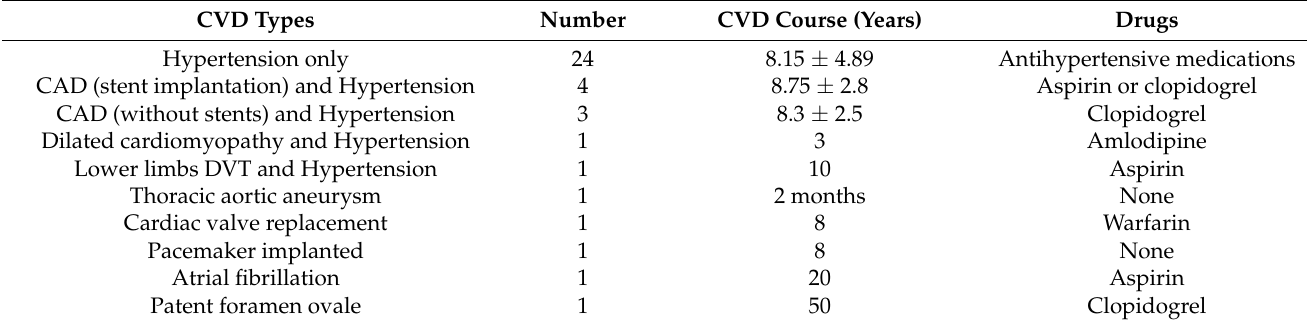
Table 2. Types of cardiovascular